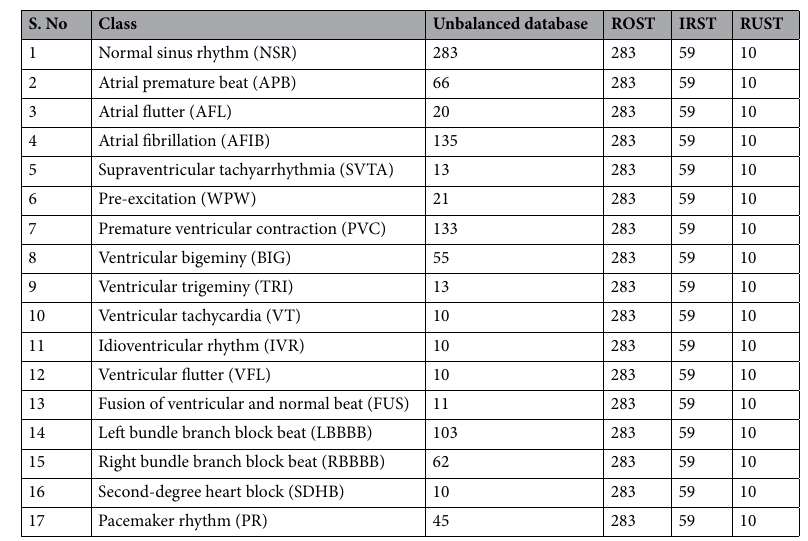
Table 1. Comparison of number of samples in the classes in balanced MLII ECG Database with number of samples in the classes in unbalanced MLII ECG database.